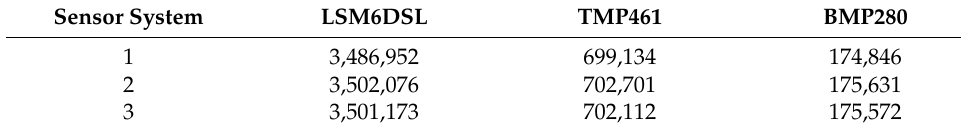
Table 2. Number of samples acquired per sensor system and per individual